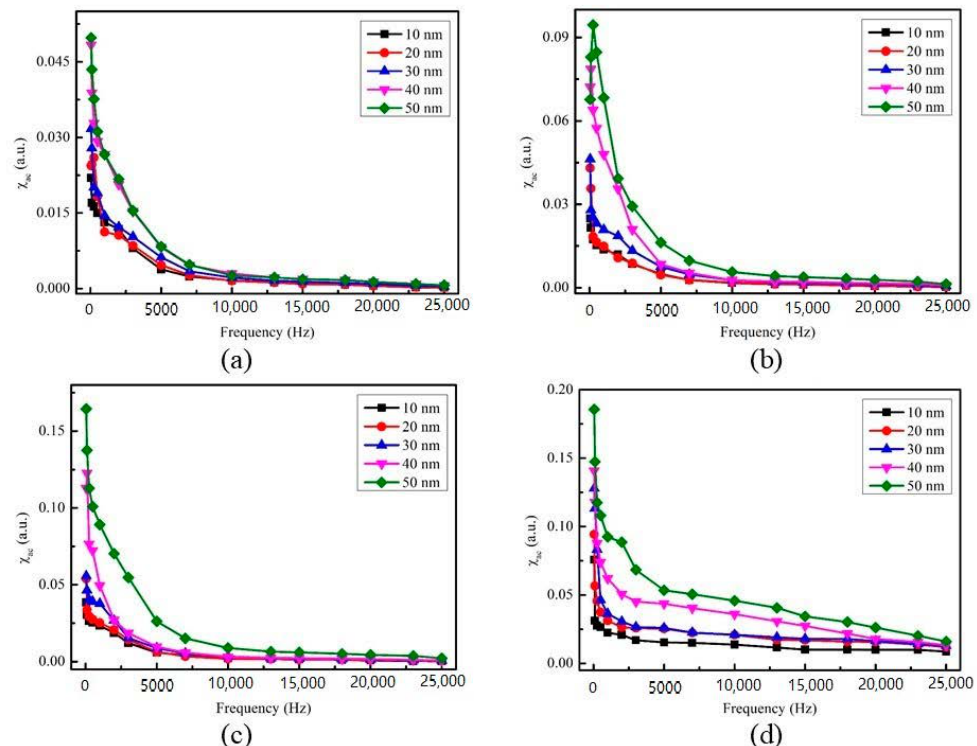
Figure 5. The low-frequency alternate-current magnetic susceptibility ( χ ac ) as a function of the frequency from 50 to 25,000 Hz. ( a ) RT, ( b ) after annealing at 100 ◦ C, ( c ) after annealing at 200 ◦ C, ( d ) after annealing at 300 ◦